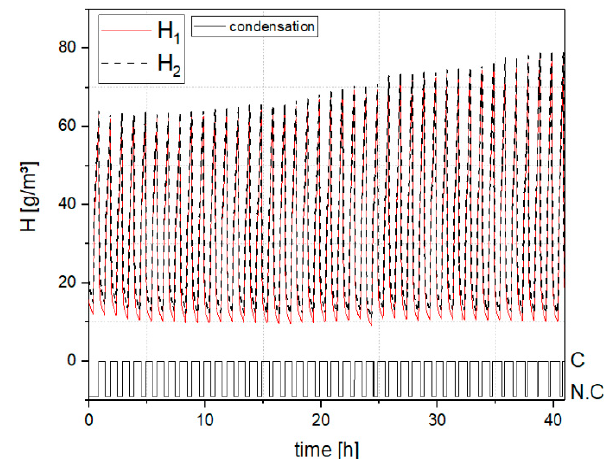
Figure 9. Absolute humidity of the air and condensation inside the housing during abnormal operation in case of a sealed battery system.